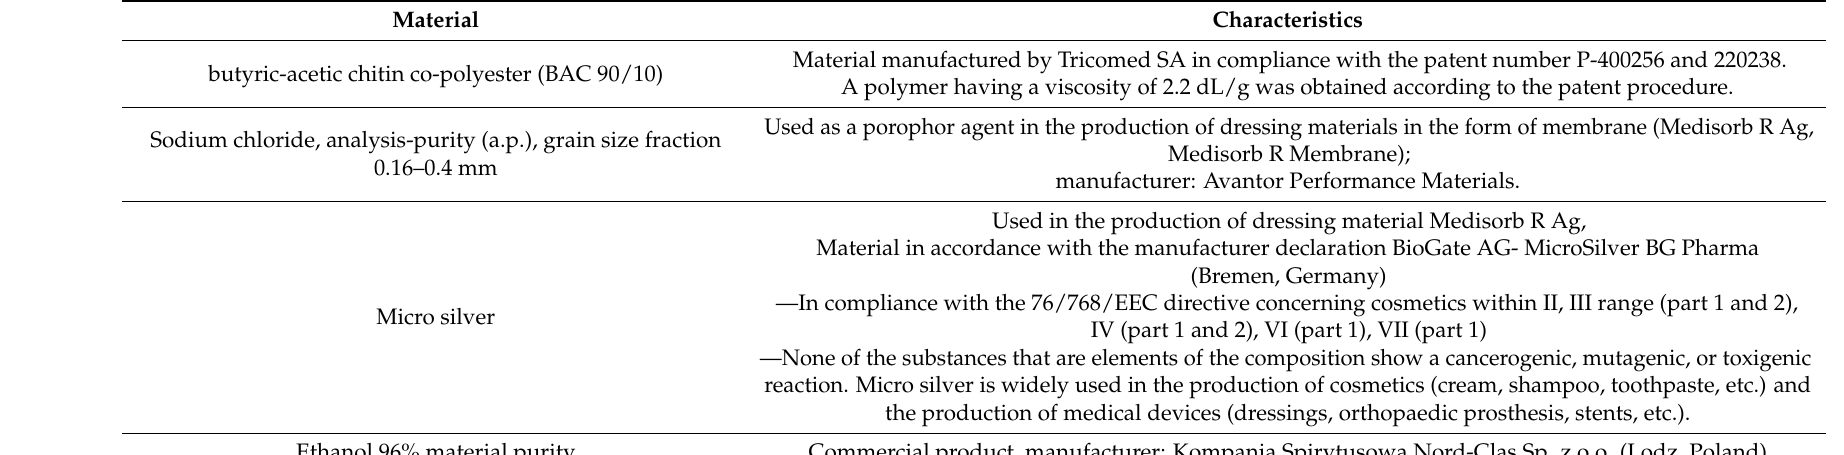
Table 2. Characteristics of the material used in production of porous dressing materials in the enlarged scale. Medisorb